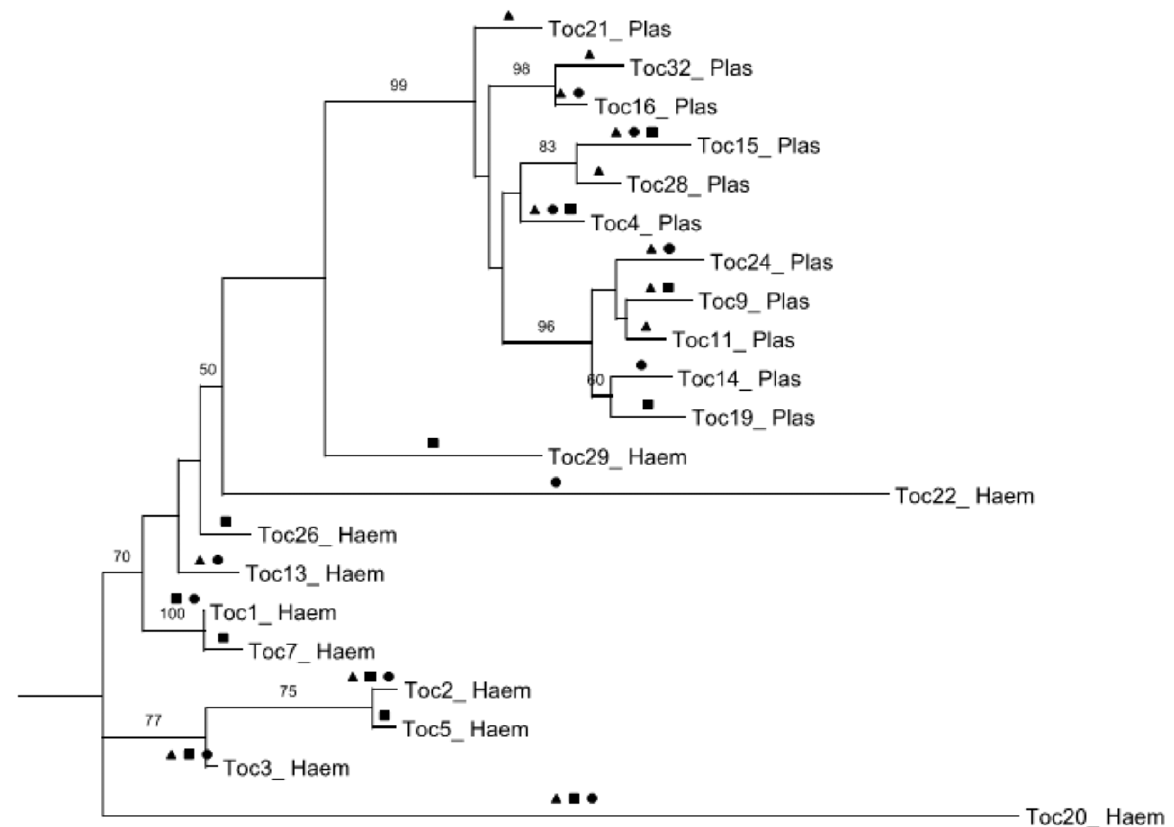
Figure 2. The Venn diagram above shows the distribution of the parasite lineages among the three areas, with the total number of lineages indicated for each of the three areas in parentheses, and the number of widespread lineages indicated within each of the sections of the diagram in parentheses. It is interesting that the mixed habitat area (CSP) has the fewest lineages uniquely found there.